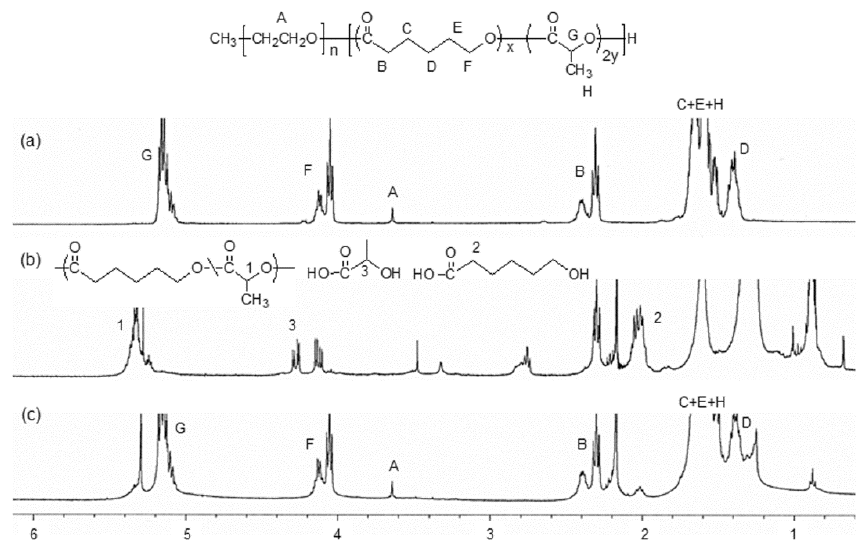
Figure 7. Proton nuclear magnetic resonance ( 1 H ‐ NMR) spectra ( a ) before; and ( b and c ) after removal of in vivo implants from rats after 3 weeks; ( b ) n ‐ hexane and ethyl ether soluble portions; and ( c ) insoluble portions.